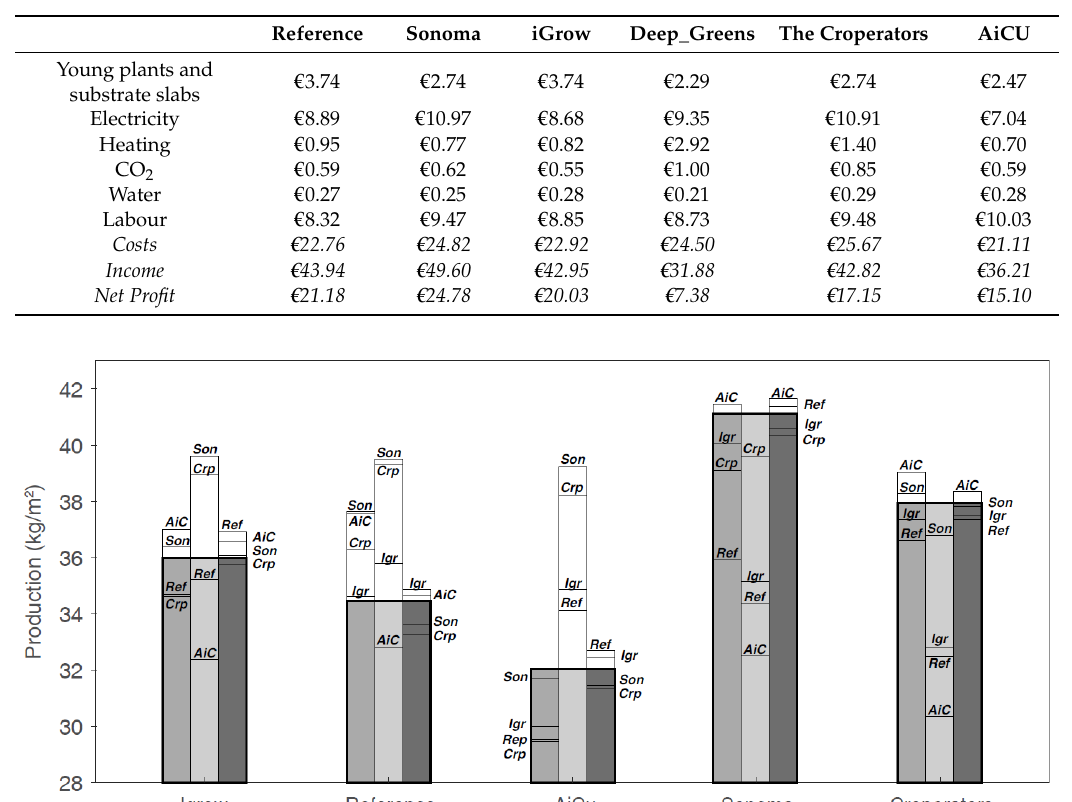
Table 2. Costs and income of different teams per m 2 greenhouse area.